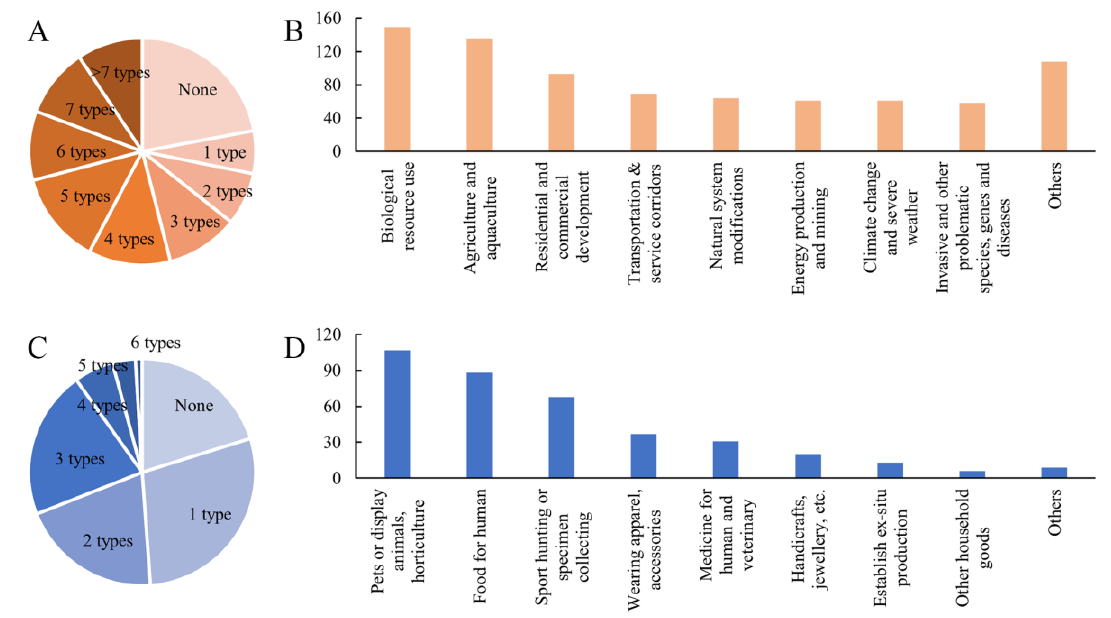
Figure 3. The threat statuses of 213 recommended umbrella species: ( A ) the proportions of recom- mended umbrella species that are impacted by varying types of threats and ( B ) the number of spe- cies that are impacted by each type of threat; ( C ) the proportions of recommended umbrella species that are harvested by humans (whole individuals, parts, or products from individuals) for varying types of end uses, and ( D ) the number of species that are used for each type of end use.